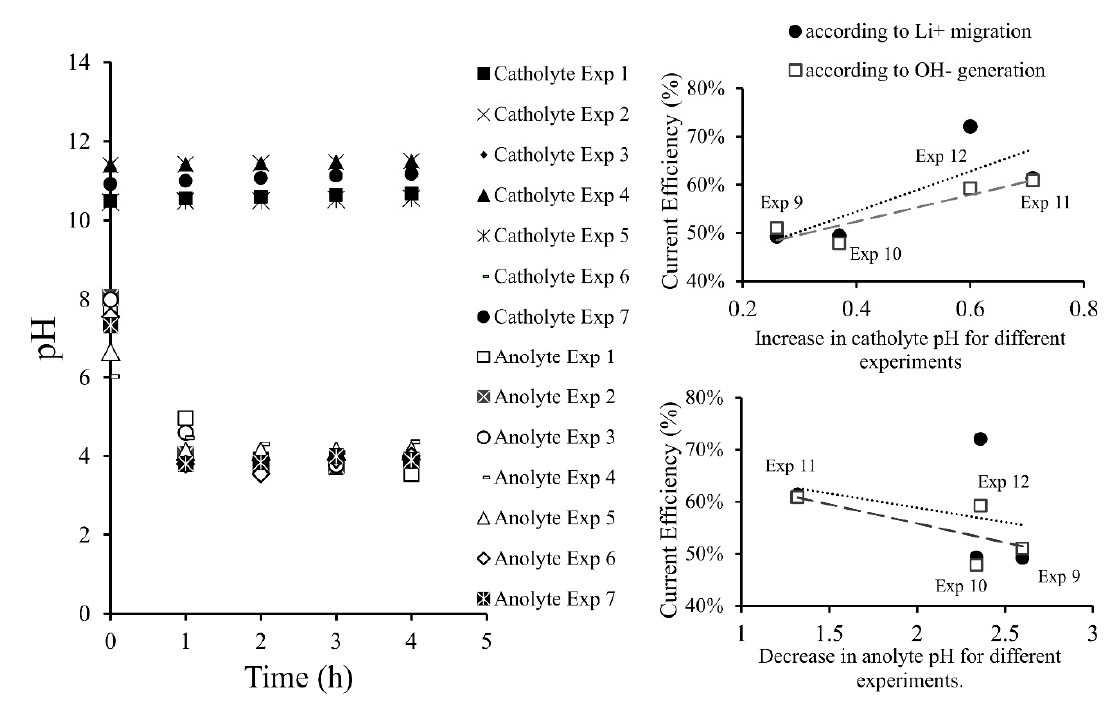
Figure 5. pH variation in electrolytes and its influence on current efficiency.